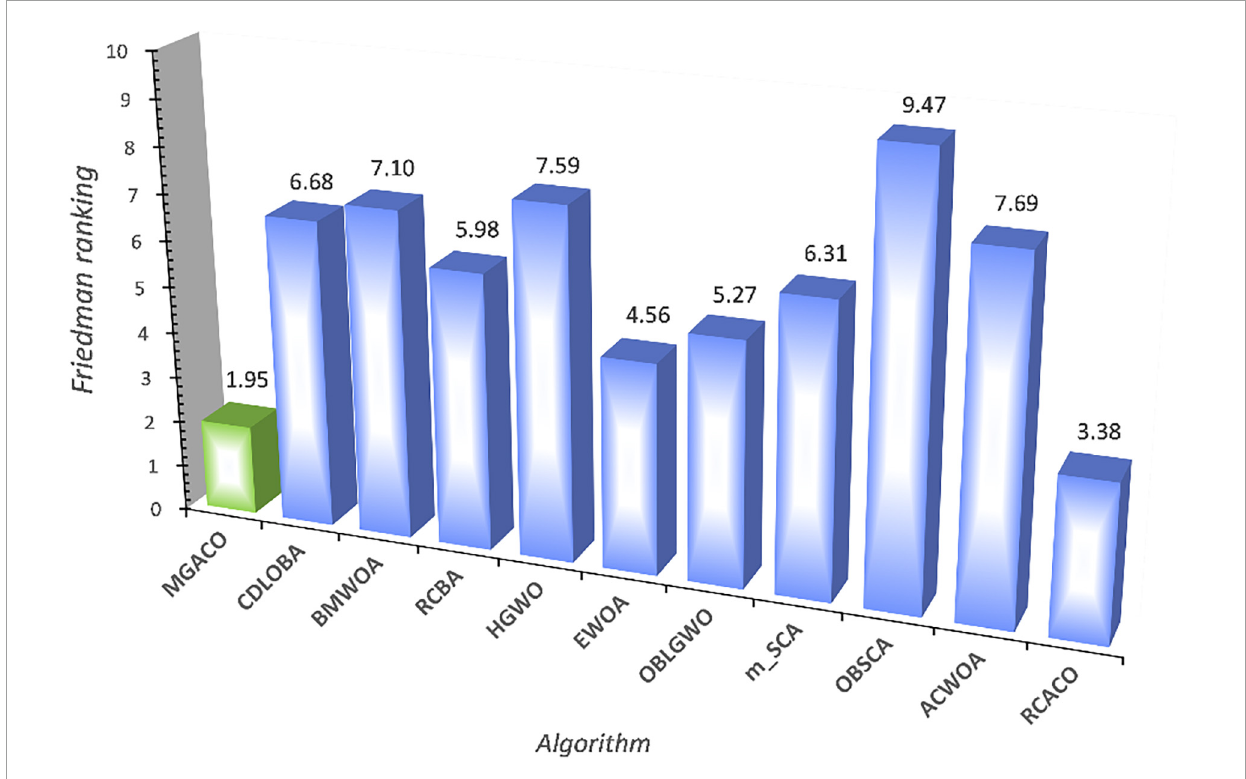
FIGURE9 Friedman test results of MGACO and its 10 advanced